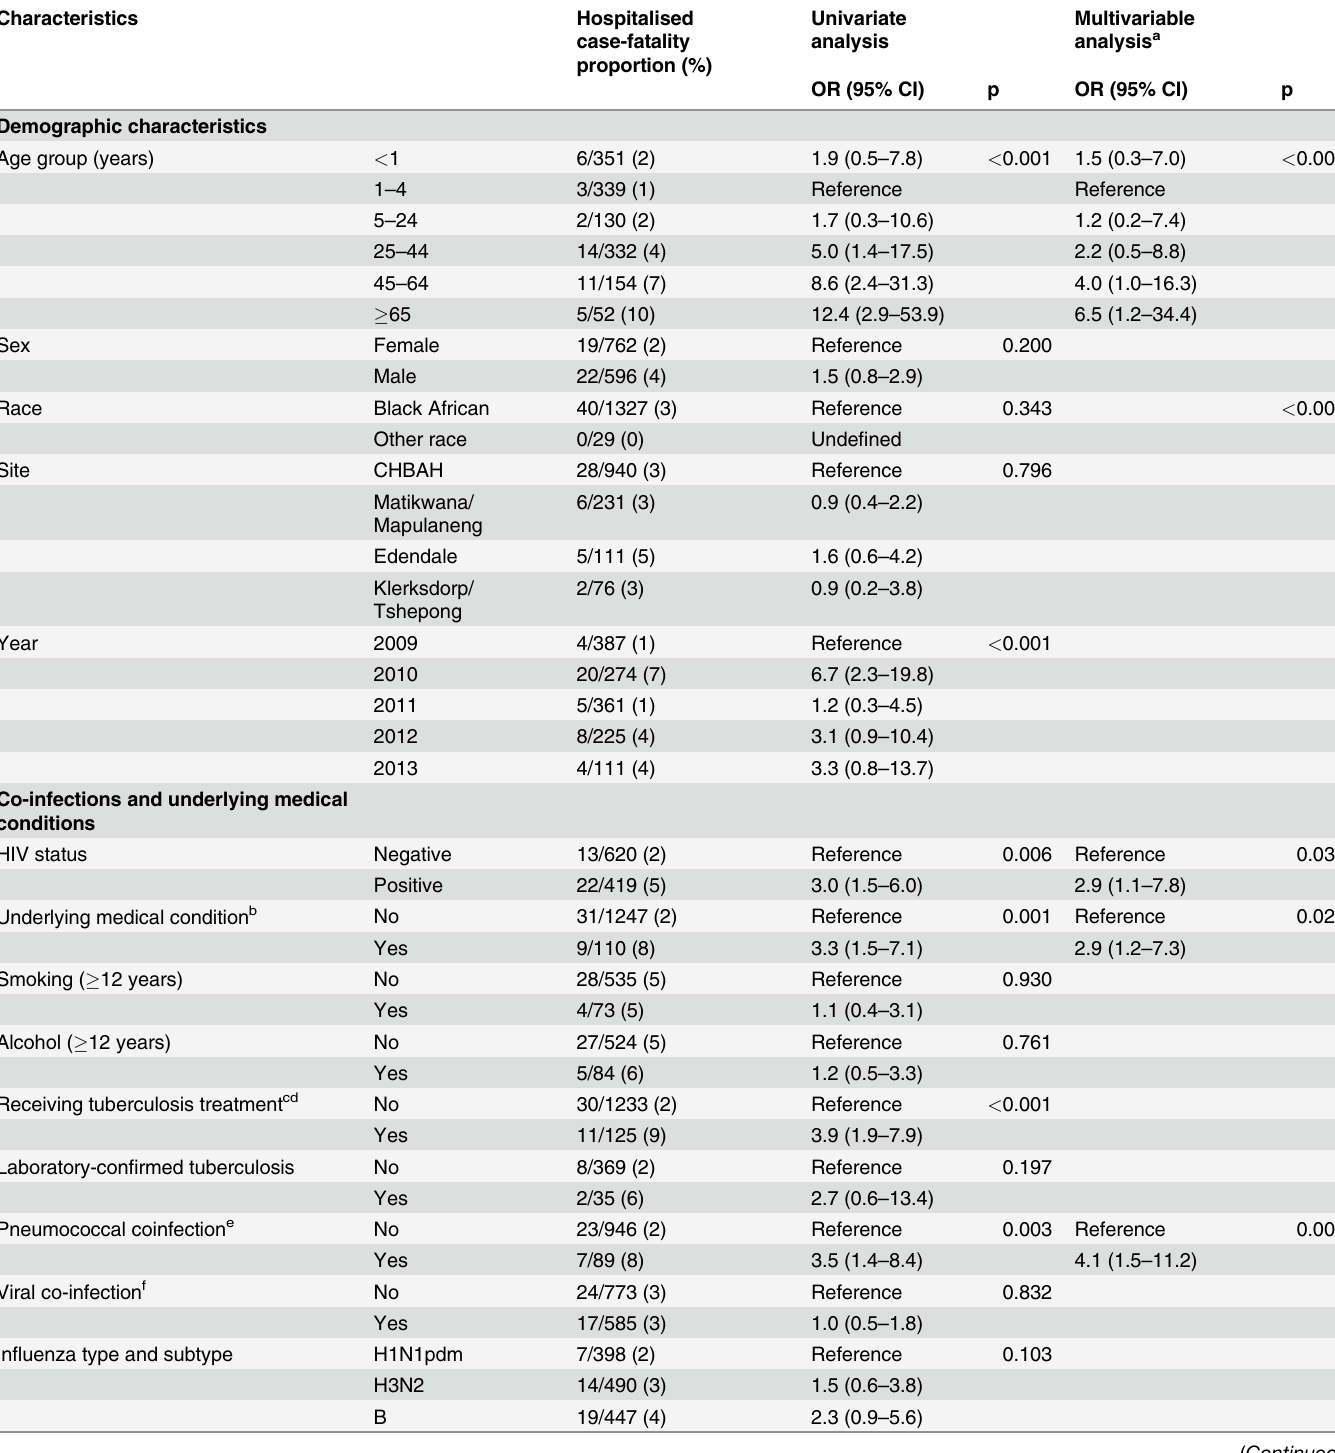
Table 1. Factors associated with death amongst hospitalised patients with in fl uenza-associated severe acute respiratory illness at four sentinel surveillance sites, South Africa, 2009 – 2013.